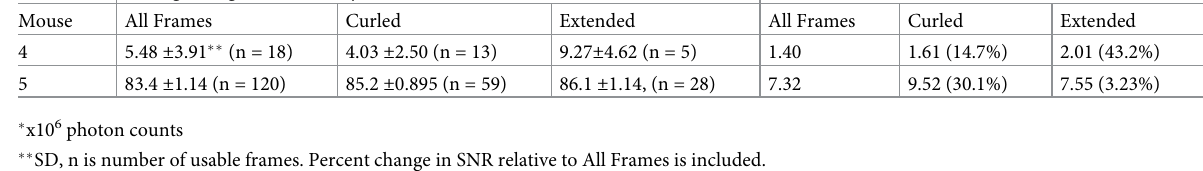
Table 1. Alternative CAIS analysis of freely moving mice imaged with photon counting mode. Average integrated intensity across frames